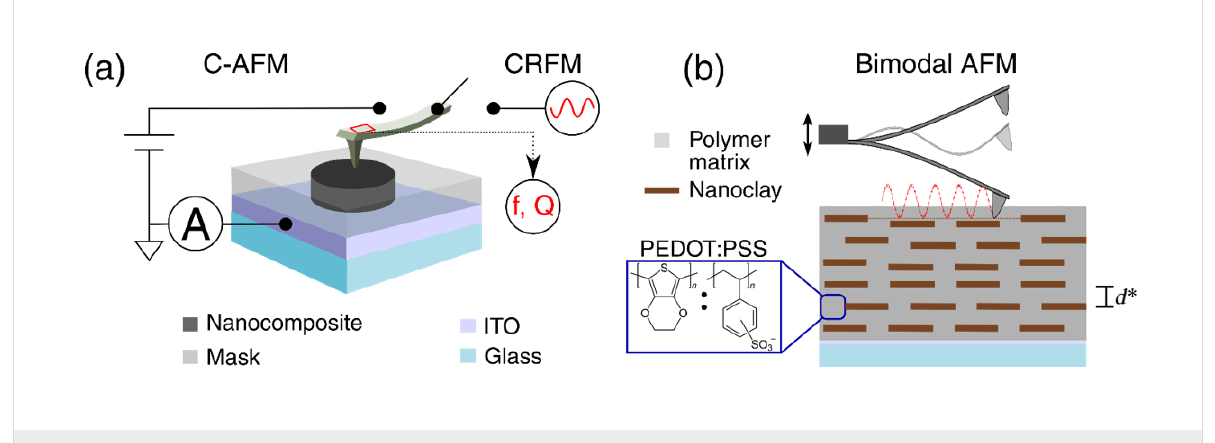
Figure 6: (a) Schematic illustration of the overall sample structure and the consecutive imaging of C-AFM and CRFM. (b) Illustration of the bimodal AFM setup and detailed nanocomposite description, including the expected sample response from the high-pressure treatment (red sinusoidal line).